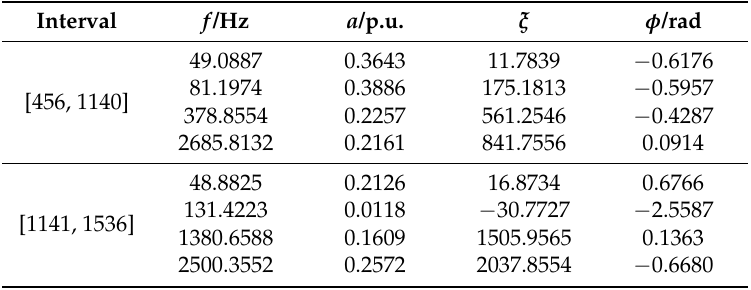
Table 7. Parameters identification of case 1.